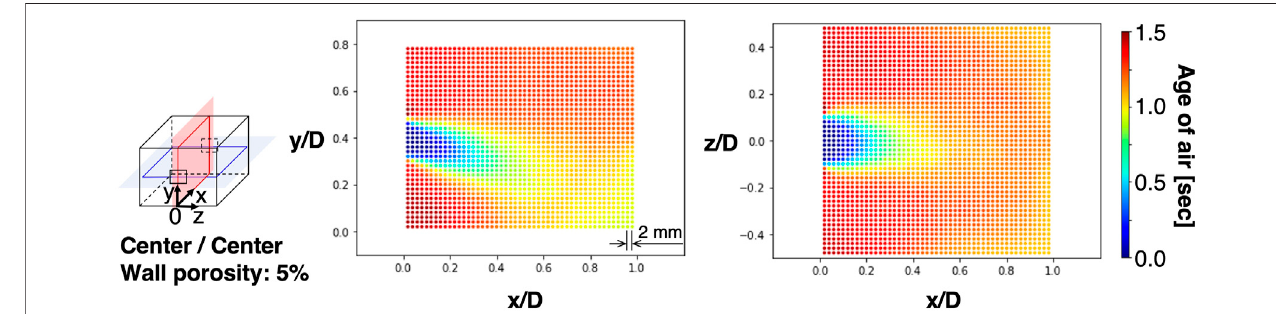
FIGURE 7 | Distribution of mean age of air at sample points on vertical and horizontal planes through the center of the building.